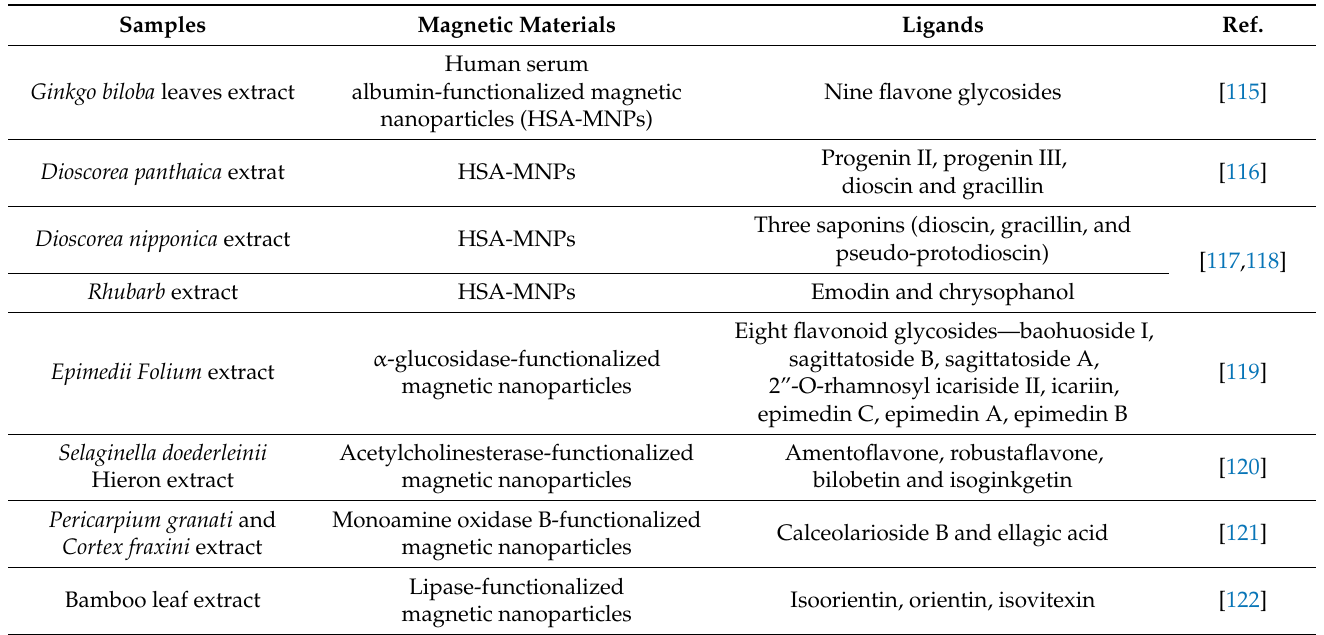
Table 4. The application of magnetite nanoparticles in the ligand